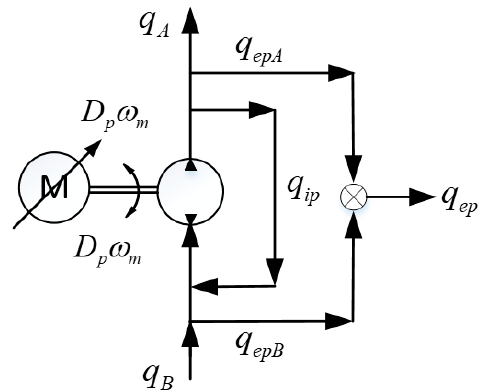
Figure 3. Hydraulic pump flow distribution.